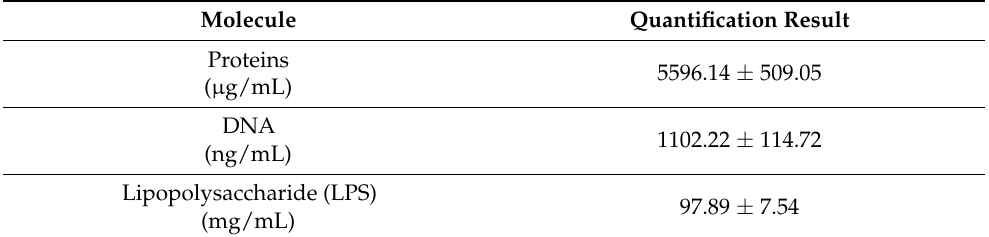
Table 1. Incorporation of pathogen-associated molecular patterns of bacterial molecules in E. coli proteoliposomes.